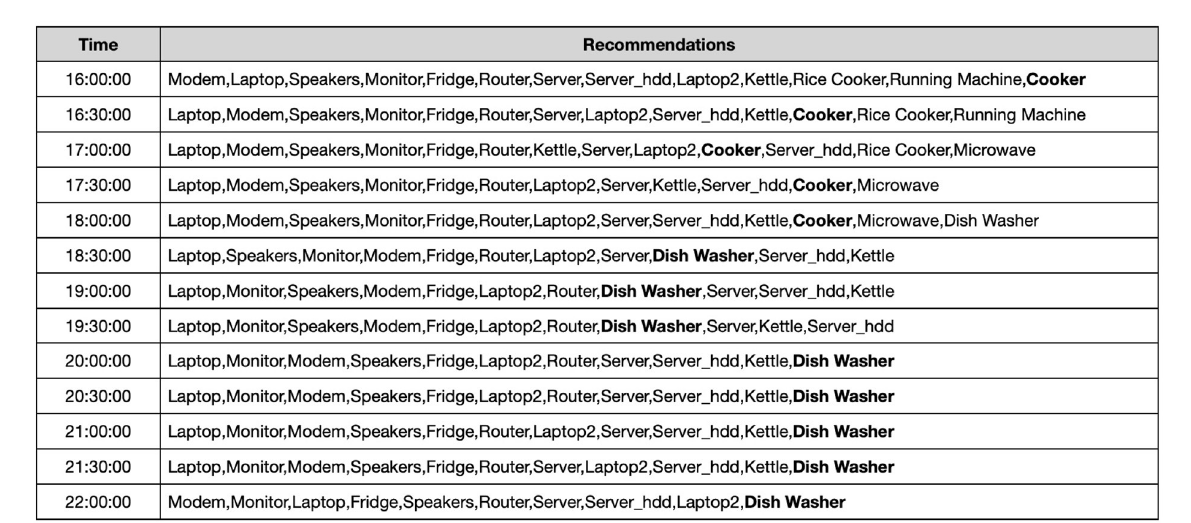
FIGURE5 Recommendations for House 2 (between 16:00 and 22:00).